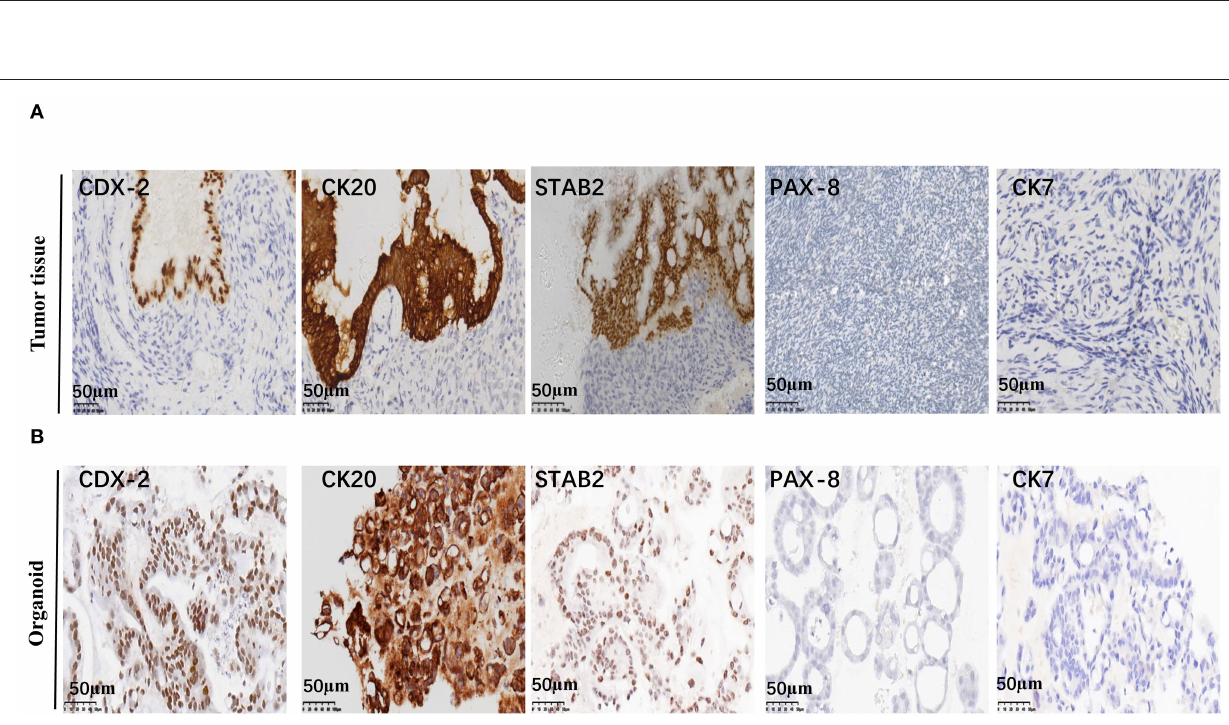
Frontiers in Medicine |